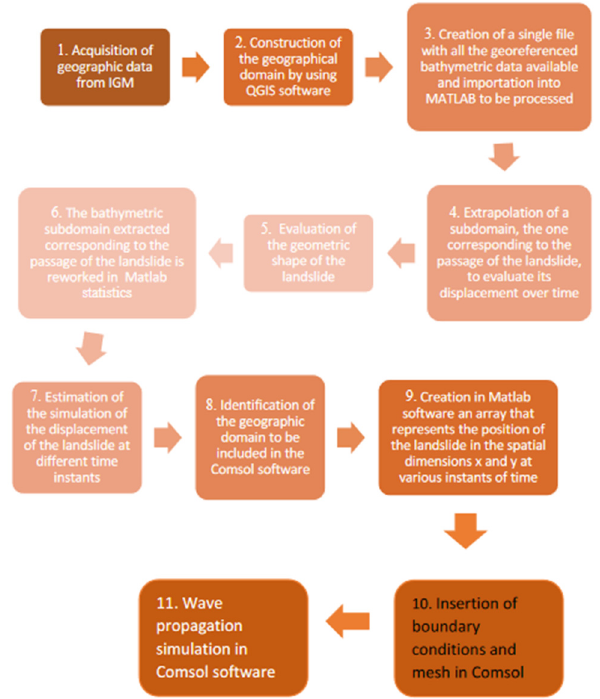
Figure 7. Methodology used in the study.